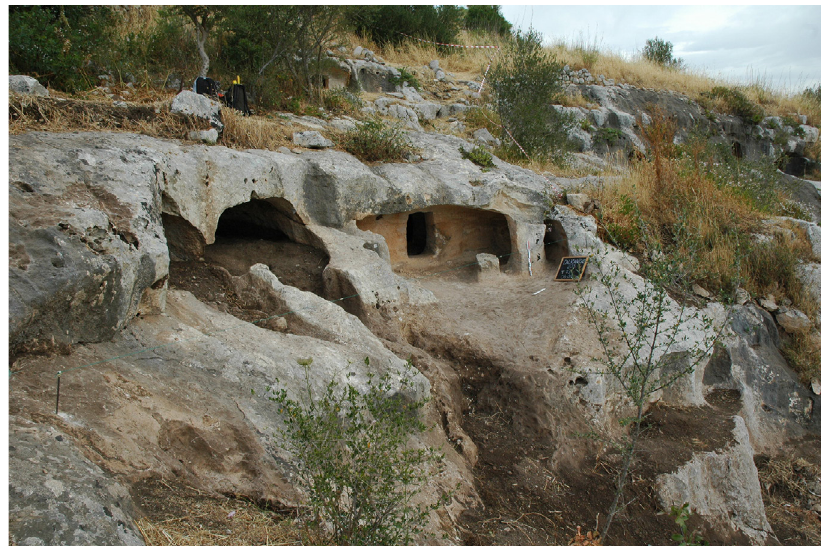
Figure 14. Tombs 71–73.